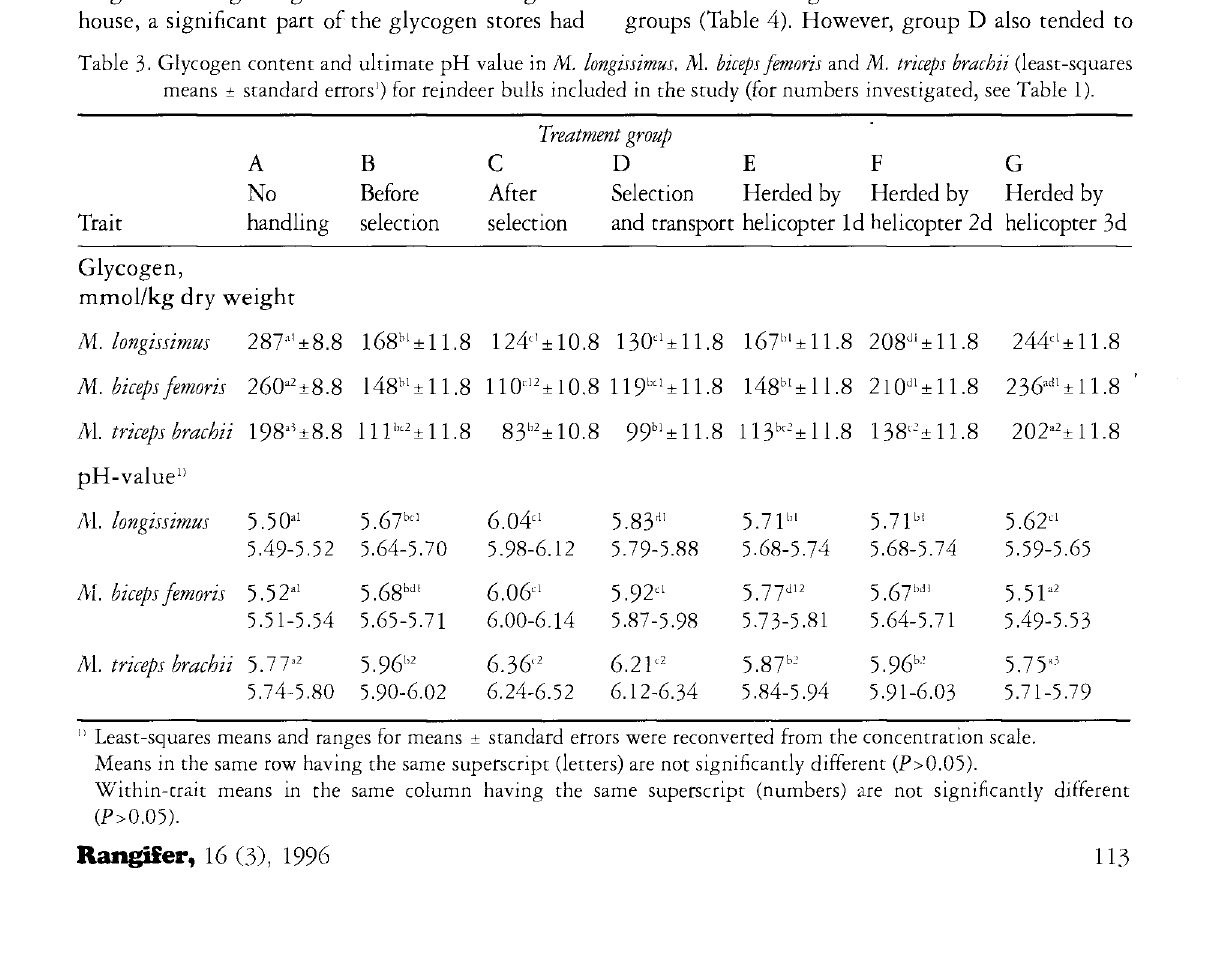
Table 3. Glycogen content and ultimate pH value in M. longissimus. Al. biceps femoris and Al. triceps brachii (least-squares means ± standard errors') for reindeer bulls included in the study (for numbers investigated, see Table